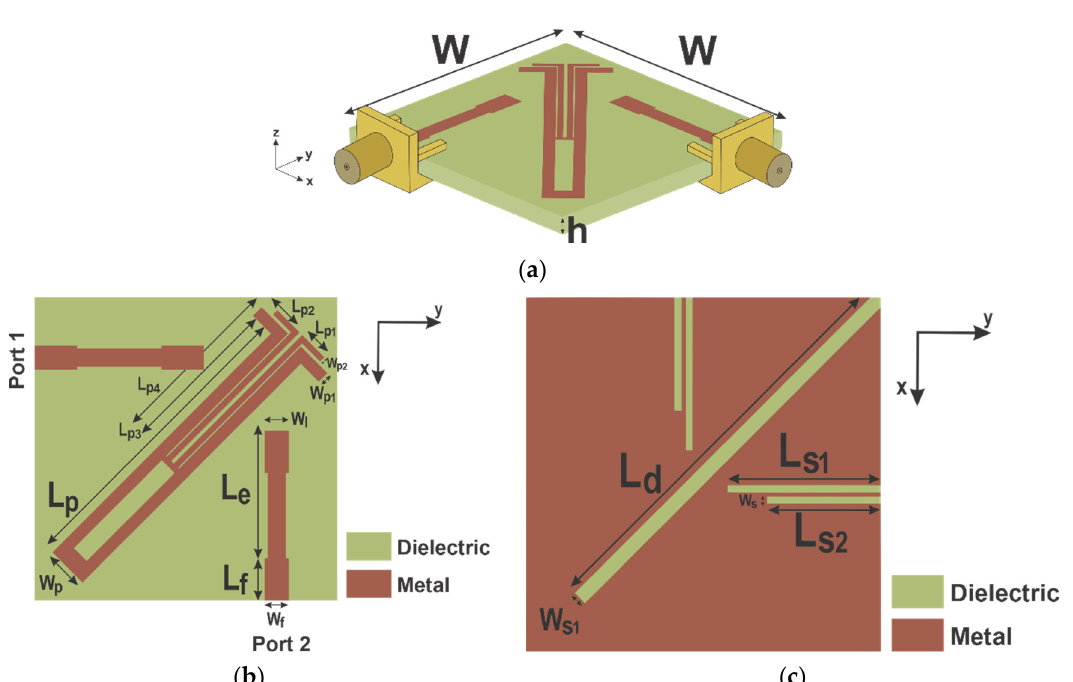
Figure 10. The proposed dual-band MIMO antenna configuration: ( a ) side view, ( b ) top view, and ( c ) bottom view.